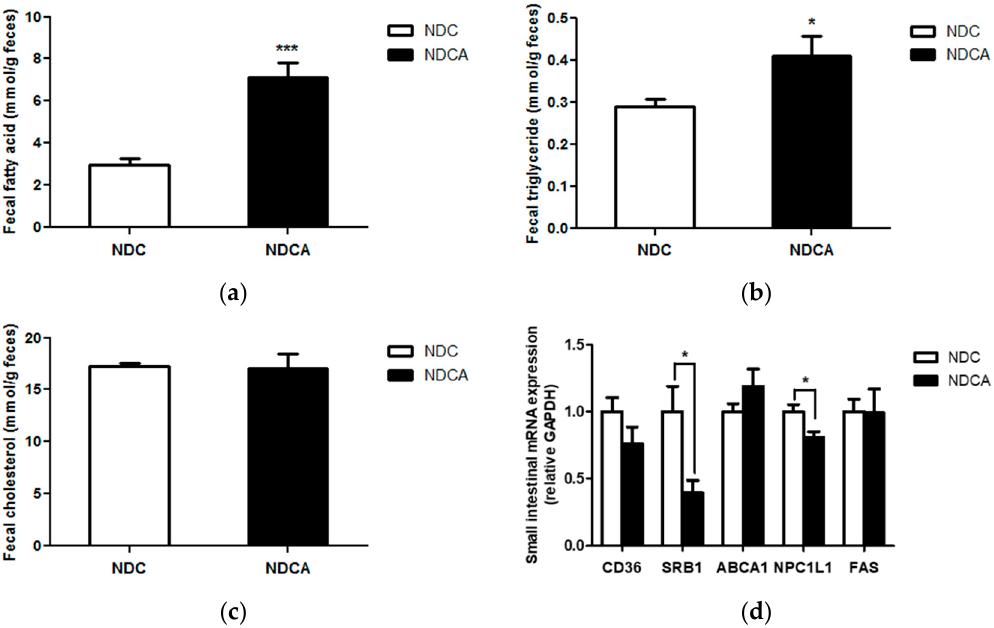
Figure 3. Effect of supplementation of a non-dairy creamer-enriched high-fat diet with D-allulose on fecal lipid excretion and small intestine RT-PCR in C57BL/6J mice fed the diet for 8 weeks: ( a ) fecal fatty acid; ( b ) fecal triglyceride; ( c ) fecal cholesterol; ( d ) small intestinal mRNA expression. Data are mean ± SE. Significant differences between the 5% D-allulose group and without D-allulose group are indicated; * p < 0.05, *** p < 0.001. NDCA, high-fat diet with non-dairy creamer + 5% D-allulose; NDC, high-fat diet with non-dairy creamer. CD36, cluster of differentiation 36; SRB1, scavenger receptor class B member 1; ABCA1, ATP-binding cassette transporter; NPC1L1, Niemann–Pick C1-Like 1; FAS, fatty acid synthase.